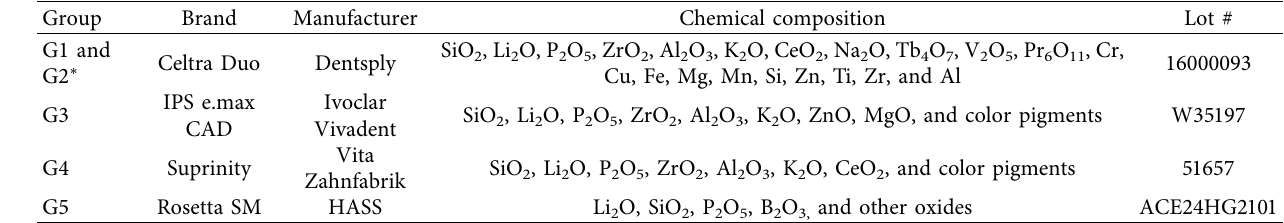
Table 1: General description of the materials in this study, manufacturers, and composition. Group